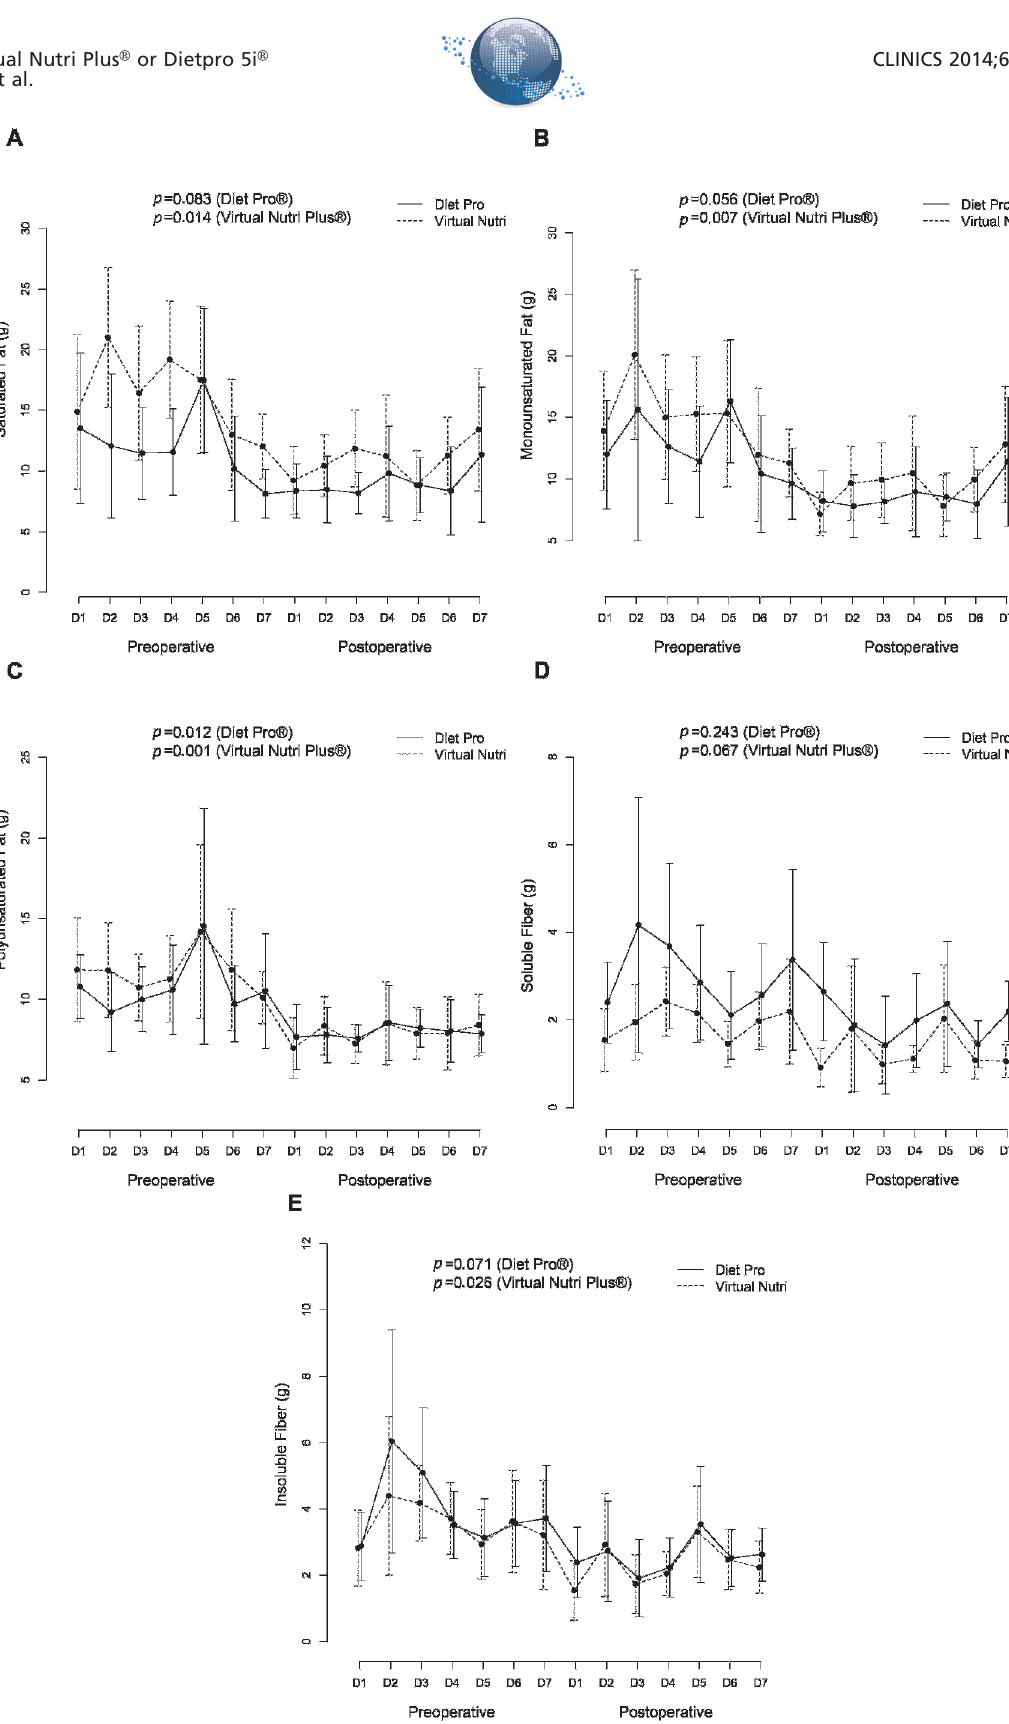
Figure 2 - Changes in the subcategories of fat and fiber ingested by obese women with type 2 diabetes mellitus (n=10) before and 3 months after a Roux-en Y gastric bypass. Changes in the intake of: (A) saturated fat, (B) monounsaturated fat, (C) polyunsaturated fat and (D) soluble fiber and (E) insoluble